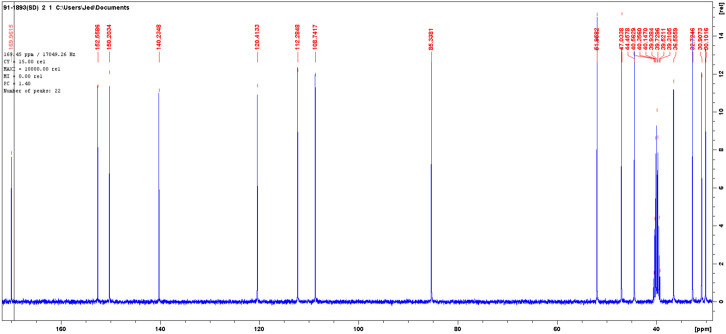
The 13C NMR spectra of isolated compound.